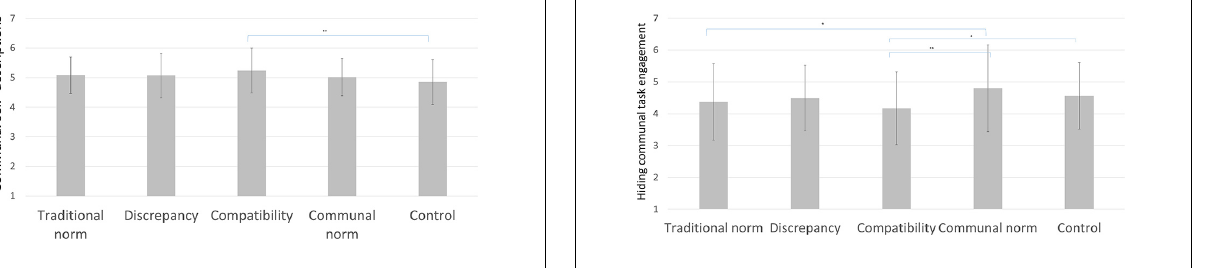
FIGURE 3 | Communal self-descriptions per condition in Study 2, with SD error bars ( ∗∗ indicates p < 0.01).